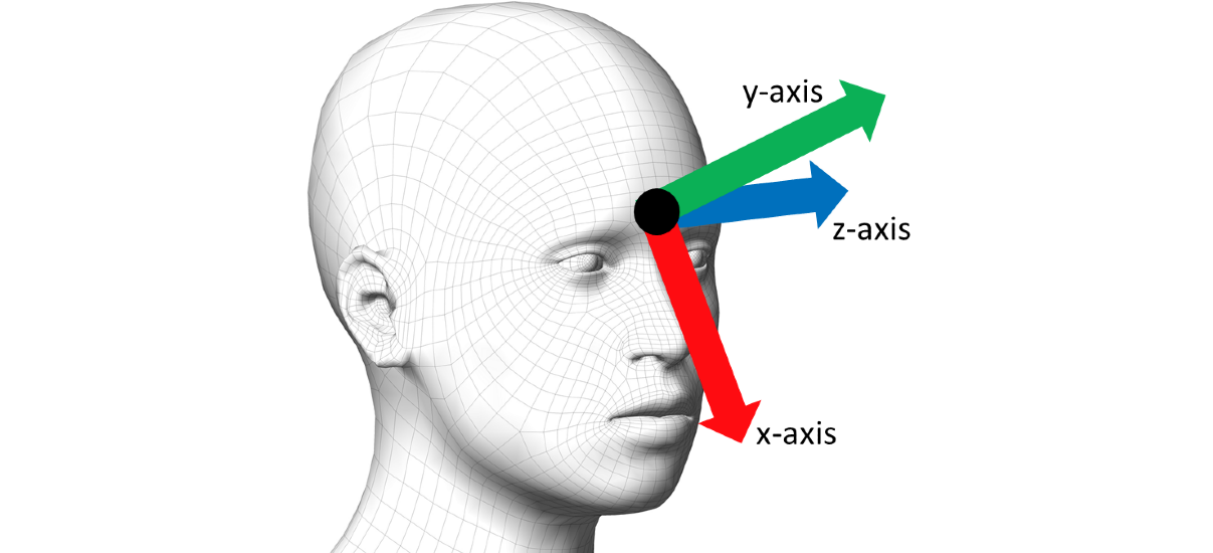
Figure 1. Position and orientation of the gyroscope on a positive airway pressure mask.